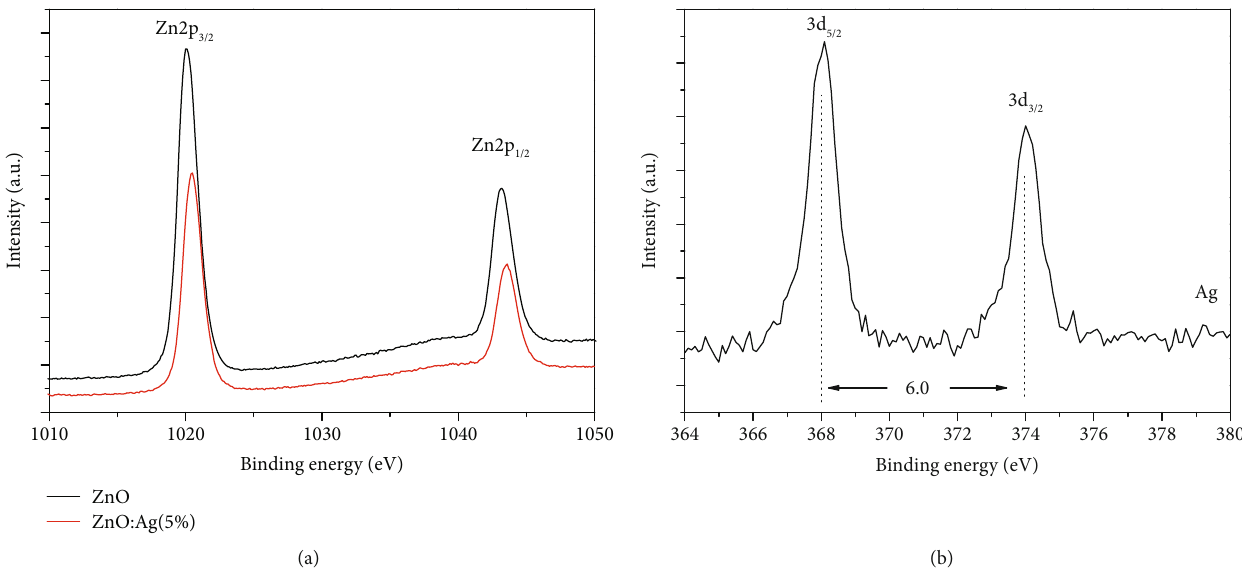
Figure 4: (a) HRXPS Zn 2p spectrum for both ZnO and ZnO:Ag (5%) thin fi lms and (b) HRXPS Ag 3d spectrum for ZnO:Ag (5%) thin fi lms. All binding energies of the XPS spectra are calibrated with reference to the C1s peak at